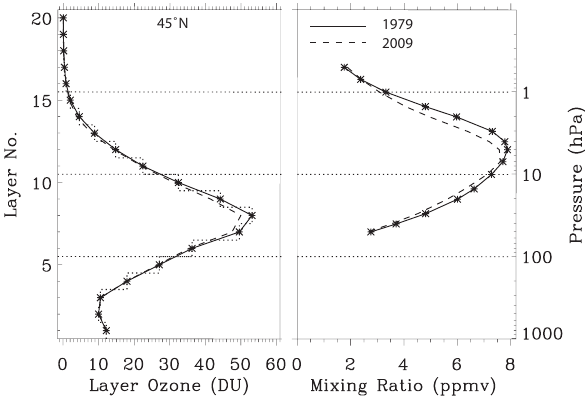
Figure 5. Left plot shows the definition of 20 SBUV layers in pressure coordinates. The symbols show the layer mid points (in logp). The right plot shows the 15 pressure levels where ozone mixing ratios are provided in the monthly zonal mean files. The annual mean ozone profiles at 45˚N latitude show significant decrease in ozone at most pressure levels over 3 decades.